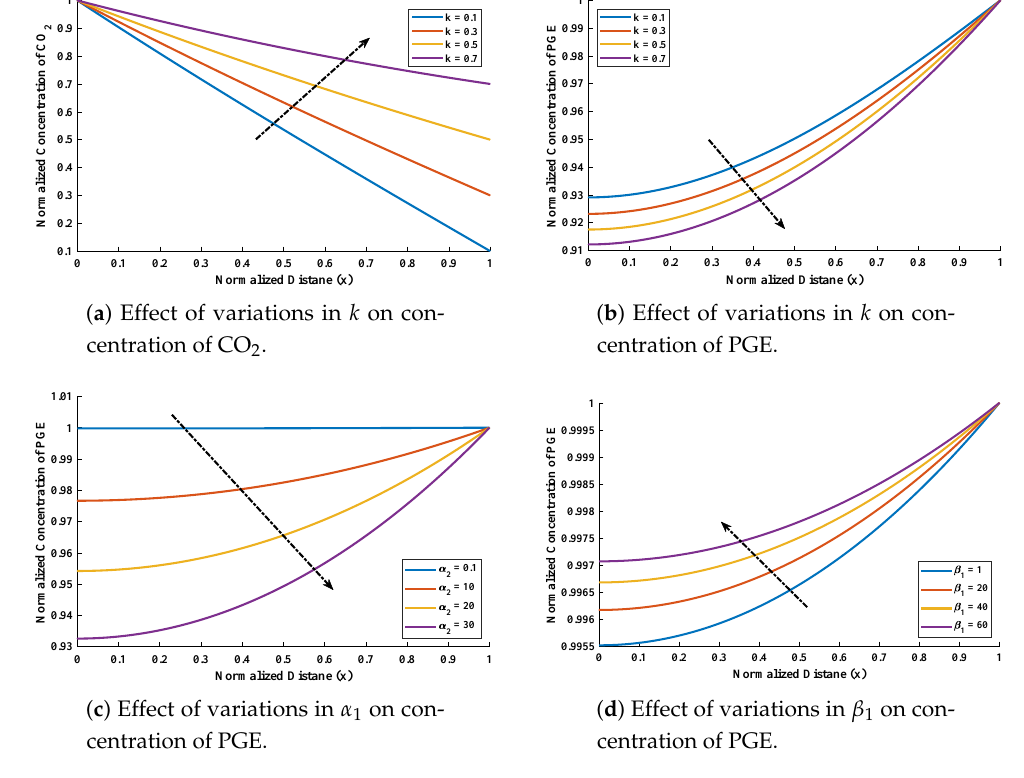
( d ) Effect of variations in β 1 on con- centration of PGE. Figure 6. Cont